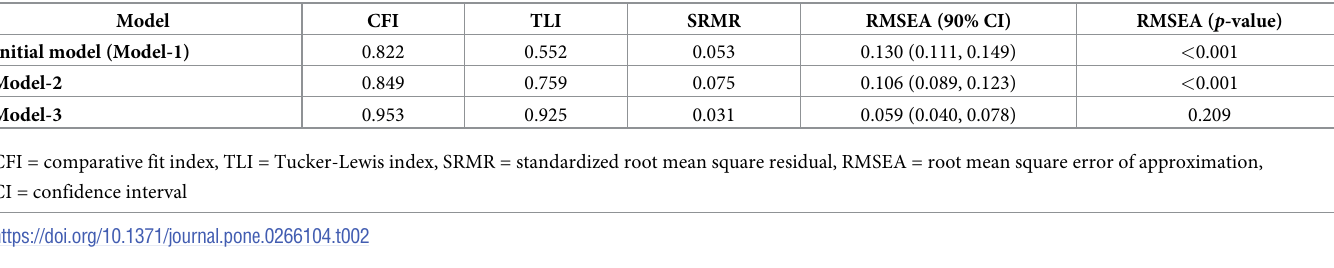
Table 2. Goodness of fit indices for hypothesized structural